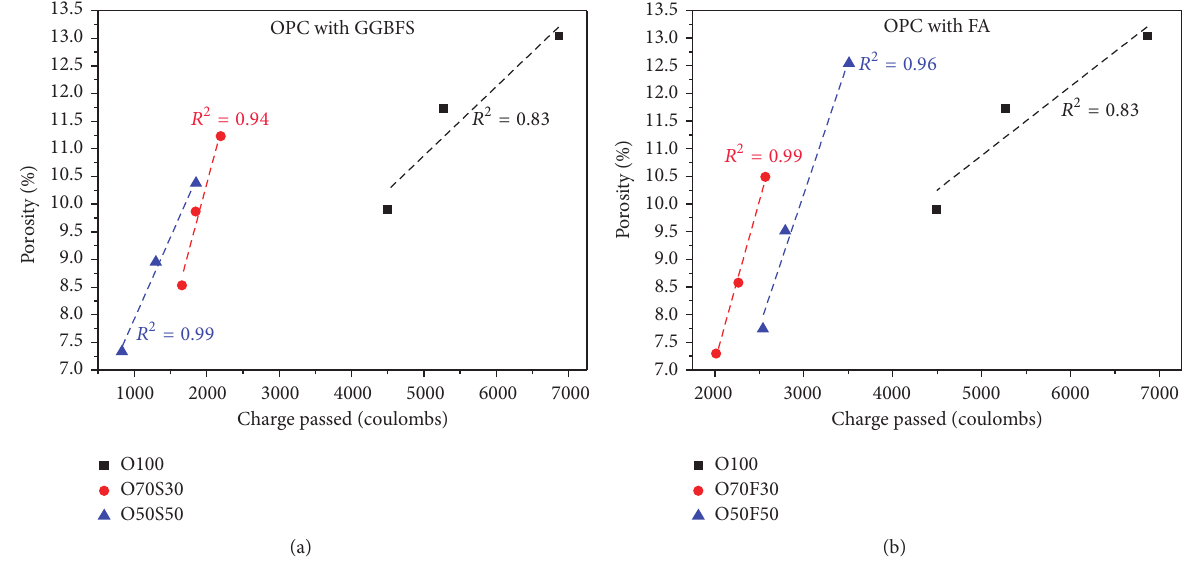
Figure 9: Correlation graph between charge passed coulomb versus porosity: (a) GGBFS in HPC and (b) FA in HPC. Table 5: Constants “ 𝑎 ” and “ 𝑏 ” and regressions coefficients 𝑅 2